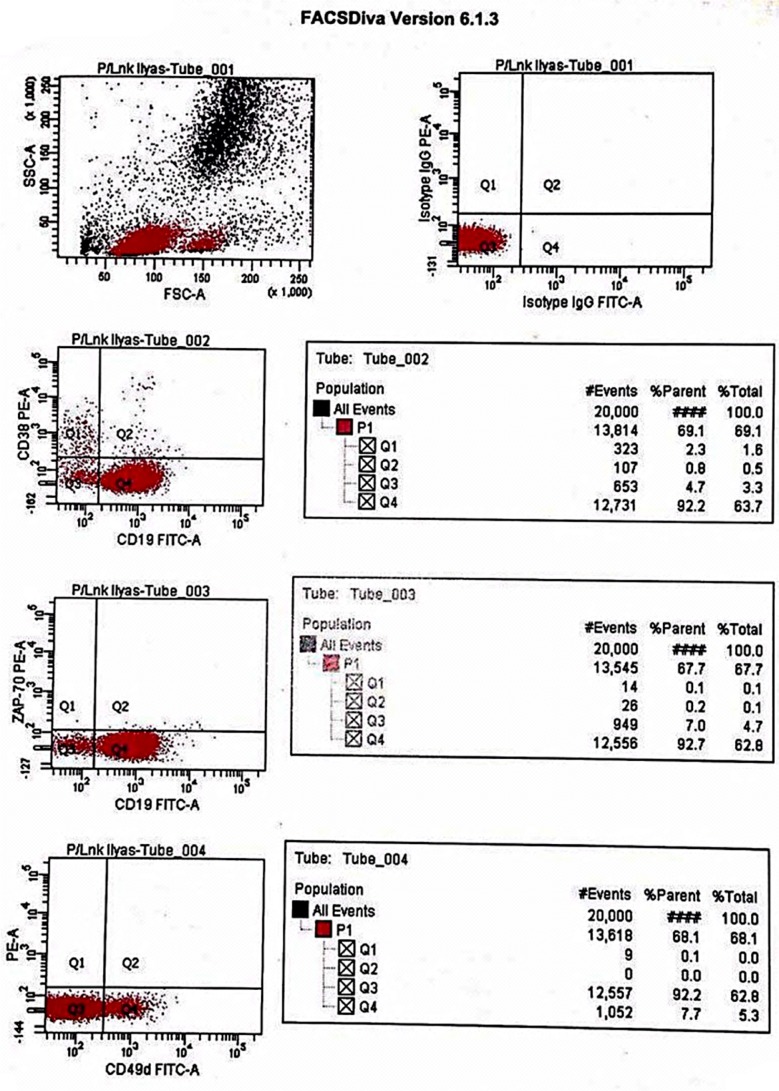
Dot-plot for Zap-70, CD38 and CD49d.